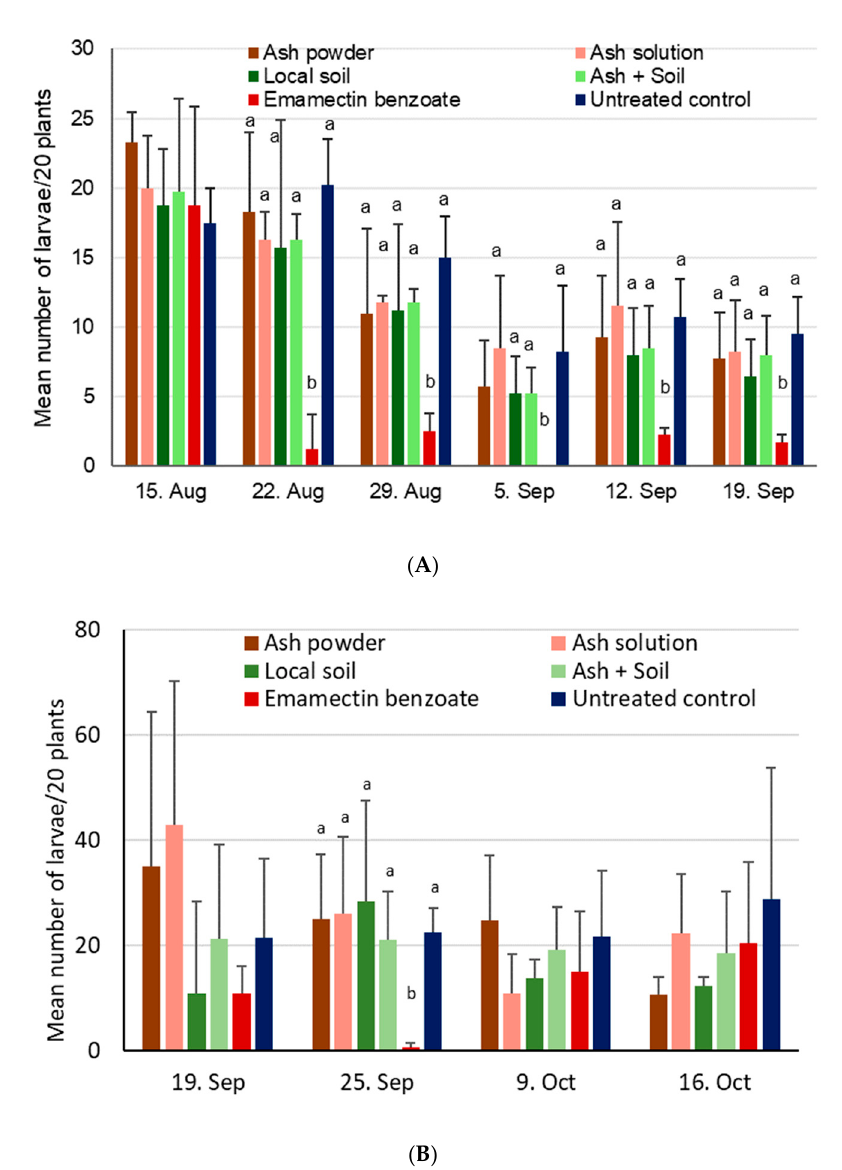
Figure 7. Mean number of FAW larvae + SD found on 20 maize plants after application of ash- or soil-based treatments during vegetative growing stages conducted in the 2018 season. Within a given date, treatment bars sharing the same letters are not significantly different from each other. ( A ) Site 1 near Wa, Upper West, Ghana, where treatments were applied on 16 August, 30 August, and 13 September, ( B ) Site 2 near Accra, Ghana, where treatments were applied on 20 September and 10